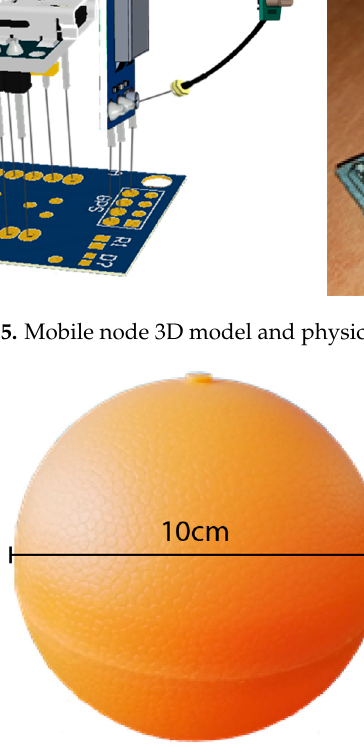
Figure 6. Mobile node lightweight plastic container.